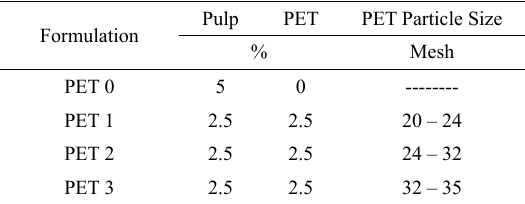
Table 1. Formulation of fiber cement